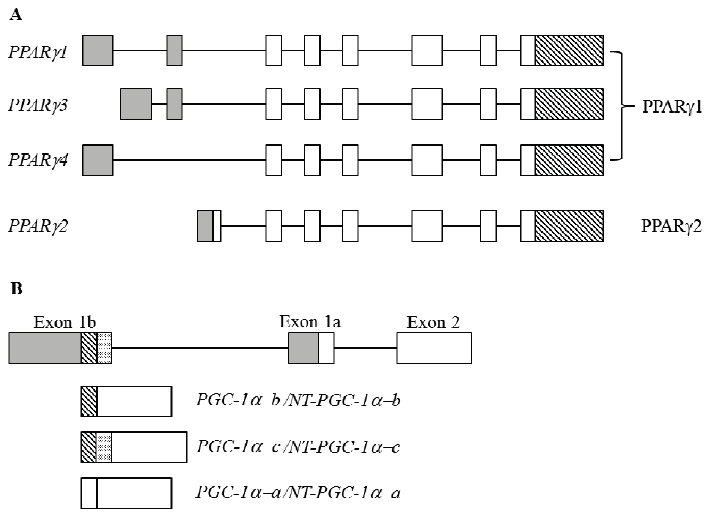
Figure 3. ( A ) Schematic diagram represents the human PPAR γ gene and alternatively spliced transcripts. The gray rectangles with different sizes represent the 5 ′ untranslated regions (UTRs), and the backslash rectangles represent the 3 ′ untranslated regions (UTRs). The open rectangles represent the coding exons; ( B ) Schematic diagram shows the composition of N-termini of murine PGC-1 α gene. The gray, backslash and dotted rectangles represent the different 5 ′ untranslated regions (UTRs), and the open rectangles represent the coding